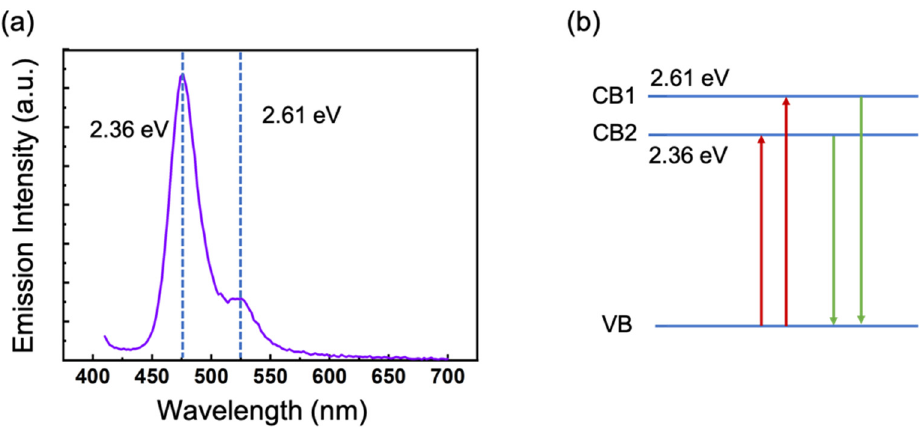
Figure 4. ( a ) PL spectrum of perovskite embedding in mesopores under 375 nm pumped emission. Two peaks appeared at 475 and 525 nm, which corresponded to 2.36 and 2.61 eV, respectively. ( b ) Schematic showing 475 and 525 nm photoluminescence and optical absorption.